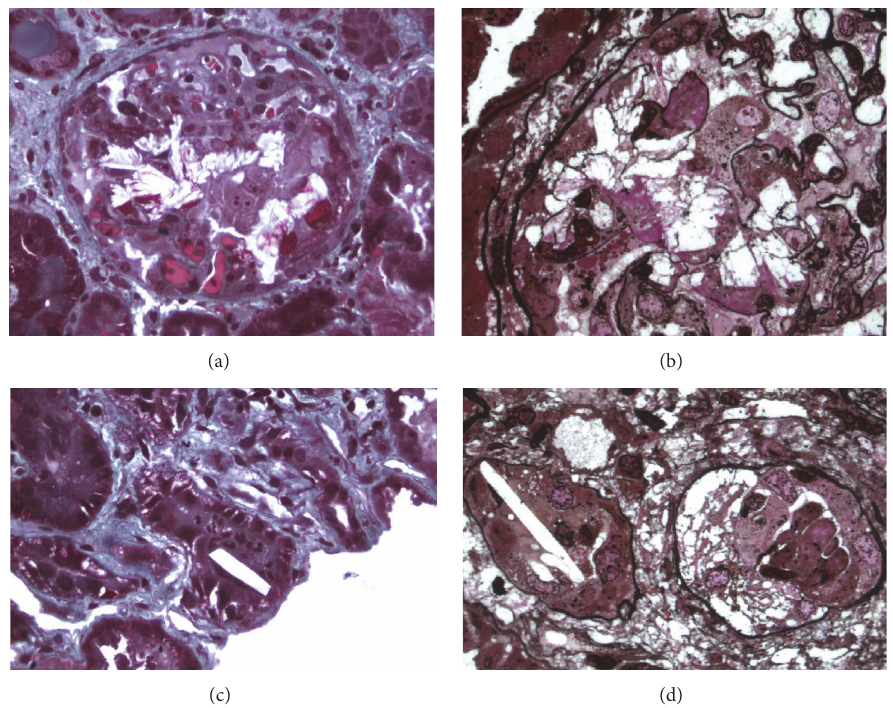
Figure 1: Foscarnet nephropathy in the kidney transplant. (a) Masson’s trichrome staining ( × 200) showed intraglomerular crystalline precipitation obstructing the capillaries and crushing the mesangium together with fibrinoid thrombi. (b) Jones methenamine silver staining ( × 400) also revealed FOS crystals within the glomerular capillaries. (c) Masson’s trichrome staining ( × 200) showed crystals that resembled short sticks with angular edges in the tubular lumen. (d) Jones methenamine silver staining ( × 400) also revealed FOS crystals within the tubular